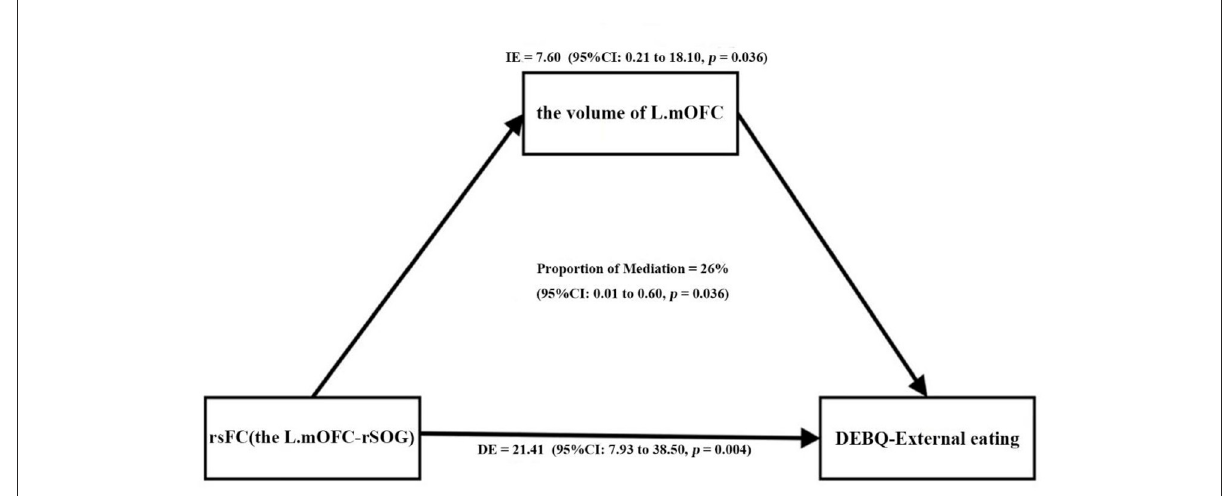
FIGURE4 The volume of the left mOFC partially mediated the relationship between rsFC (the left mOFC—rSOG) and DEBQ-external eating (Prop.mediated = 26.2%, p = 0.036). mOFC, medial orbitofrontal cortex; rsFC, resting-state functional connectivity; SOG, superior occipital gyrus; DEBQ, Dutch Eating Behavior